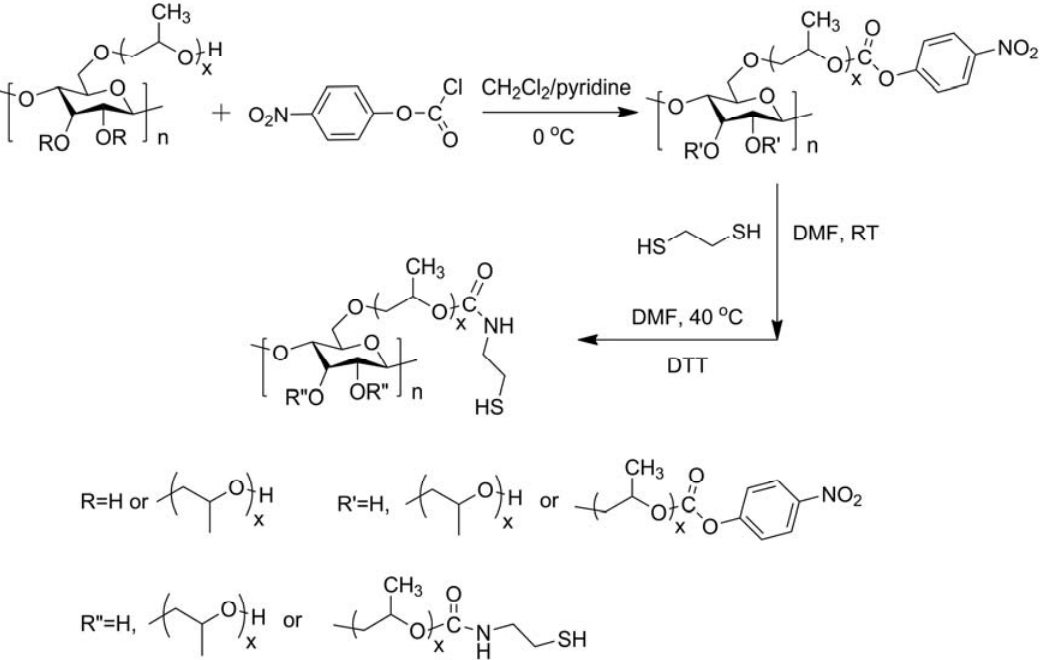
Figure 9. Synthesis route of the thiolated HPC derivatives. Reprinted with permission from [58]. Copyright 2010 Royal Society of